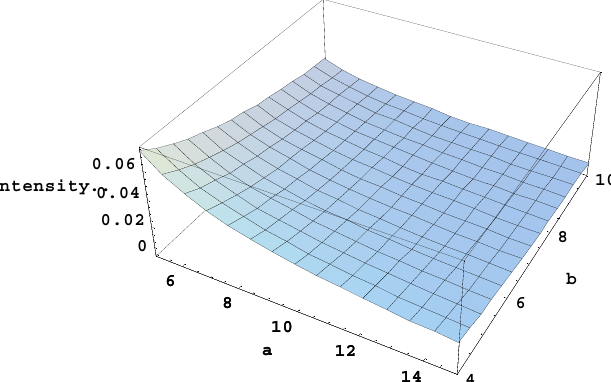
Figure 1. Spatially integrated intensity I of the most prominent satellite versus the scaled distance b. = L/ λ of Langmuir solitons in the sequence for three values of the scaled amplitude a = 3¯ h X k E 0 /(2Z r m e e ω ) of the solitons electric field: a = 10 (solid line), a = 15 (dashed line), and a = 20 (dotted line).